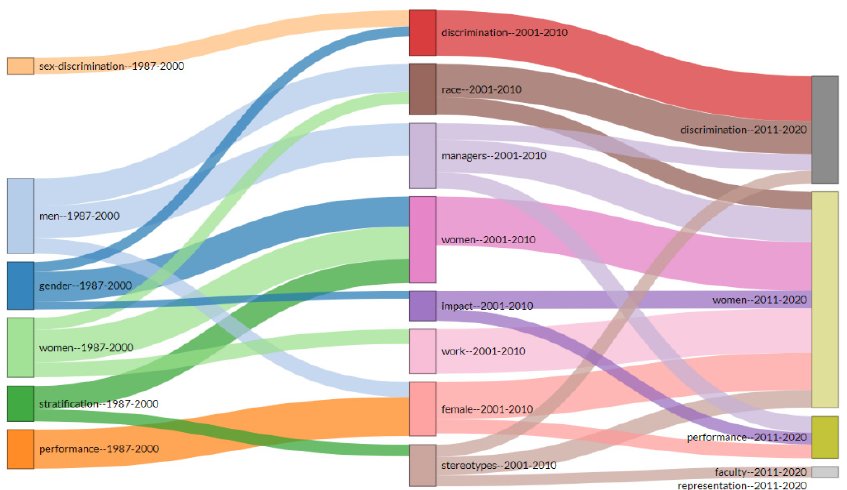
Figure 9. Thematic Figure 9. Thematic evolution.